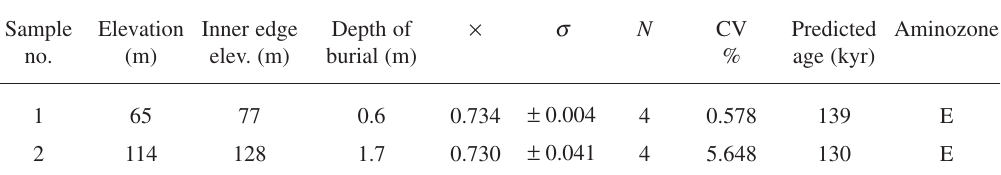
Table I. Amino acid data and predicted age of the samples. AAR analyses are presented as mean D / L aspartic acid ratio ( × ), standard deviation ( σ ) and number of shells analyzed N . Predicted ages are calculated using a value of 17.0°C for the current mean annual temperature, which is a first approximation of the long-term effective diage- netic temperature at the site (see also Hearty et al. , 1986). There is good reproducibility among the shells in the sample, as suggested by the value for the coefficient of variation CV (CV=( σ ∗ 100/ × ) (measure of